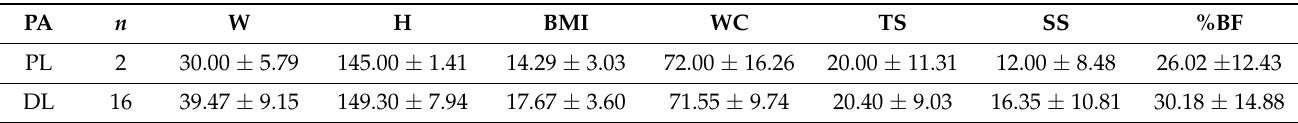
Table 7. Results of pre- and post-lockdown anthropometric variables in relation to the frequency of children who did not practice physical activity.